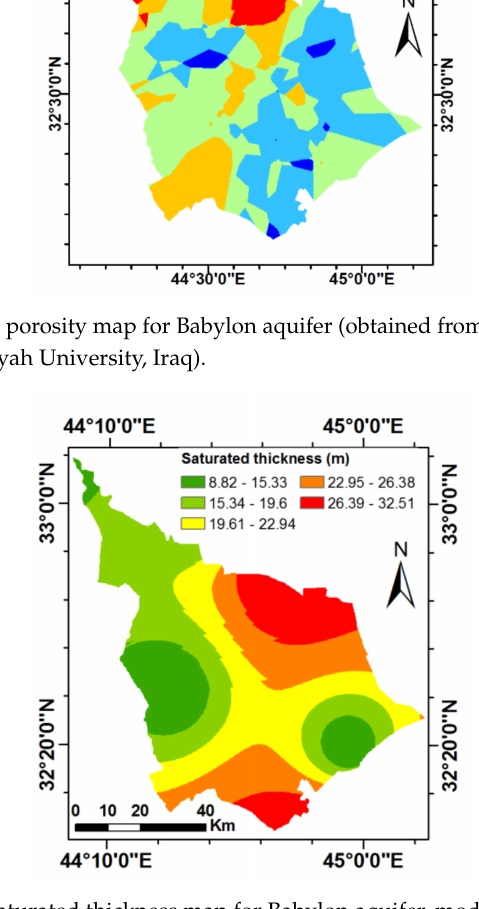
Figure 10. Saturated thickness map for Babylon aquifer, modified after